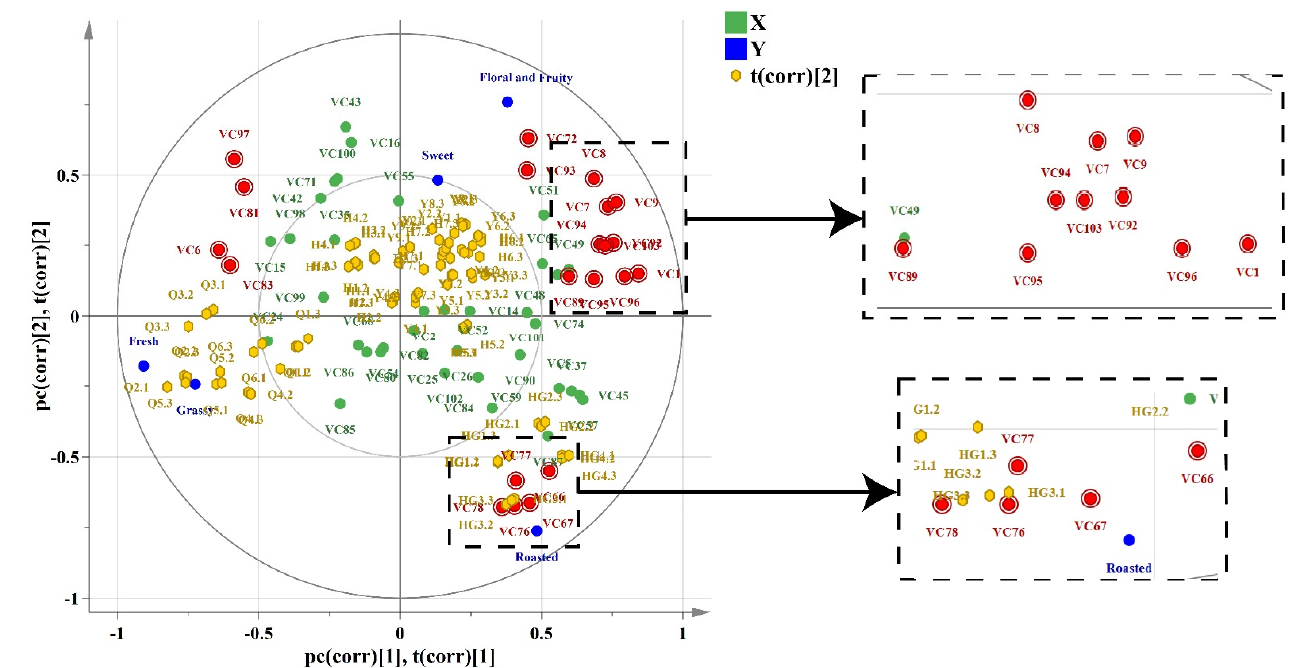
Figure 4. PLS plots for the tea samples, the sensory analysis, and active-aroma volatiles (OAV >